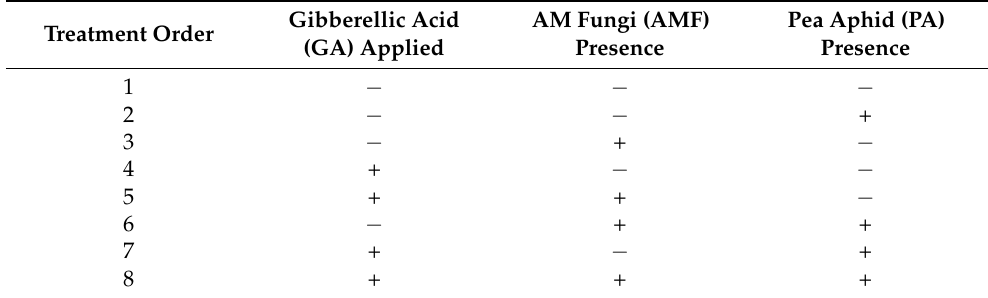
Table 1. Experimental treatments used to investigate the role of exogenous application of gibberellic acid (GA) to Medicago truncatula that were inoculated with mock inoculum or R. intraradices inoculum and infested with pea